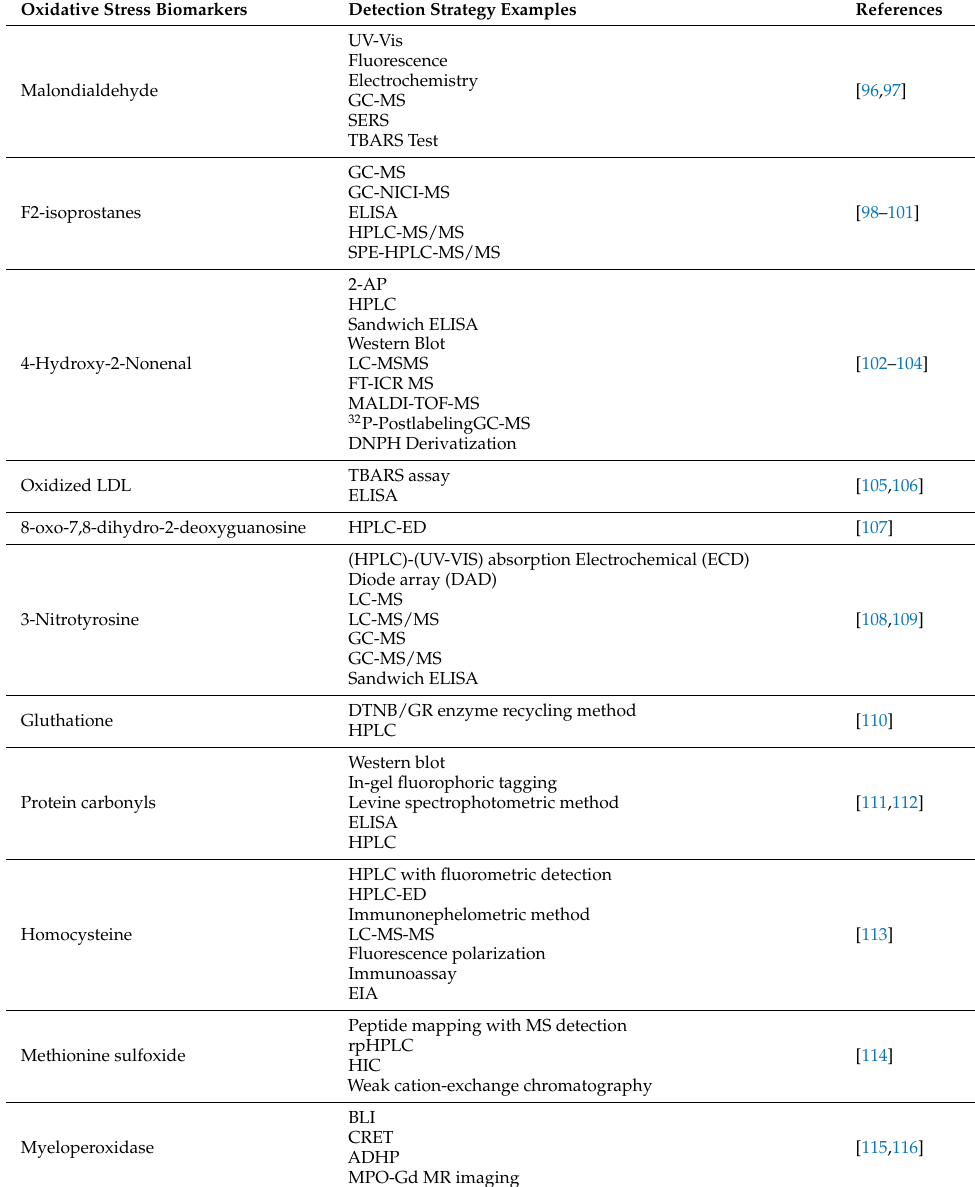
Table 2. Detection strategy of oxidative stress